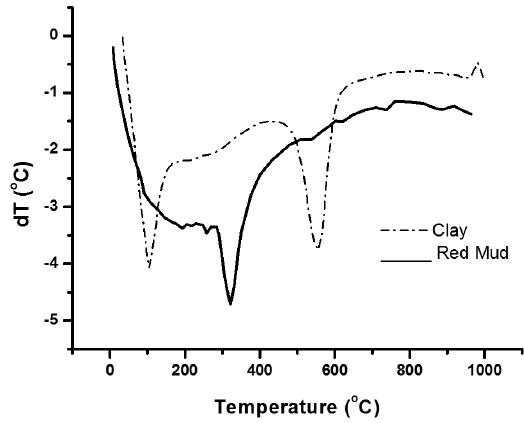
Figure 3. Gresification diagram of samples RM-70 and RM-50.